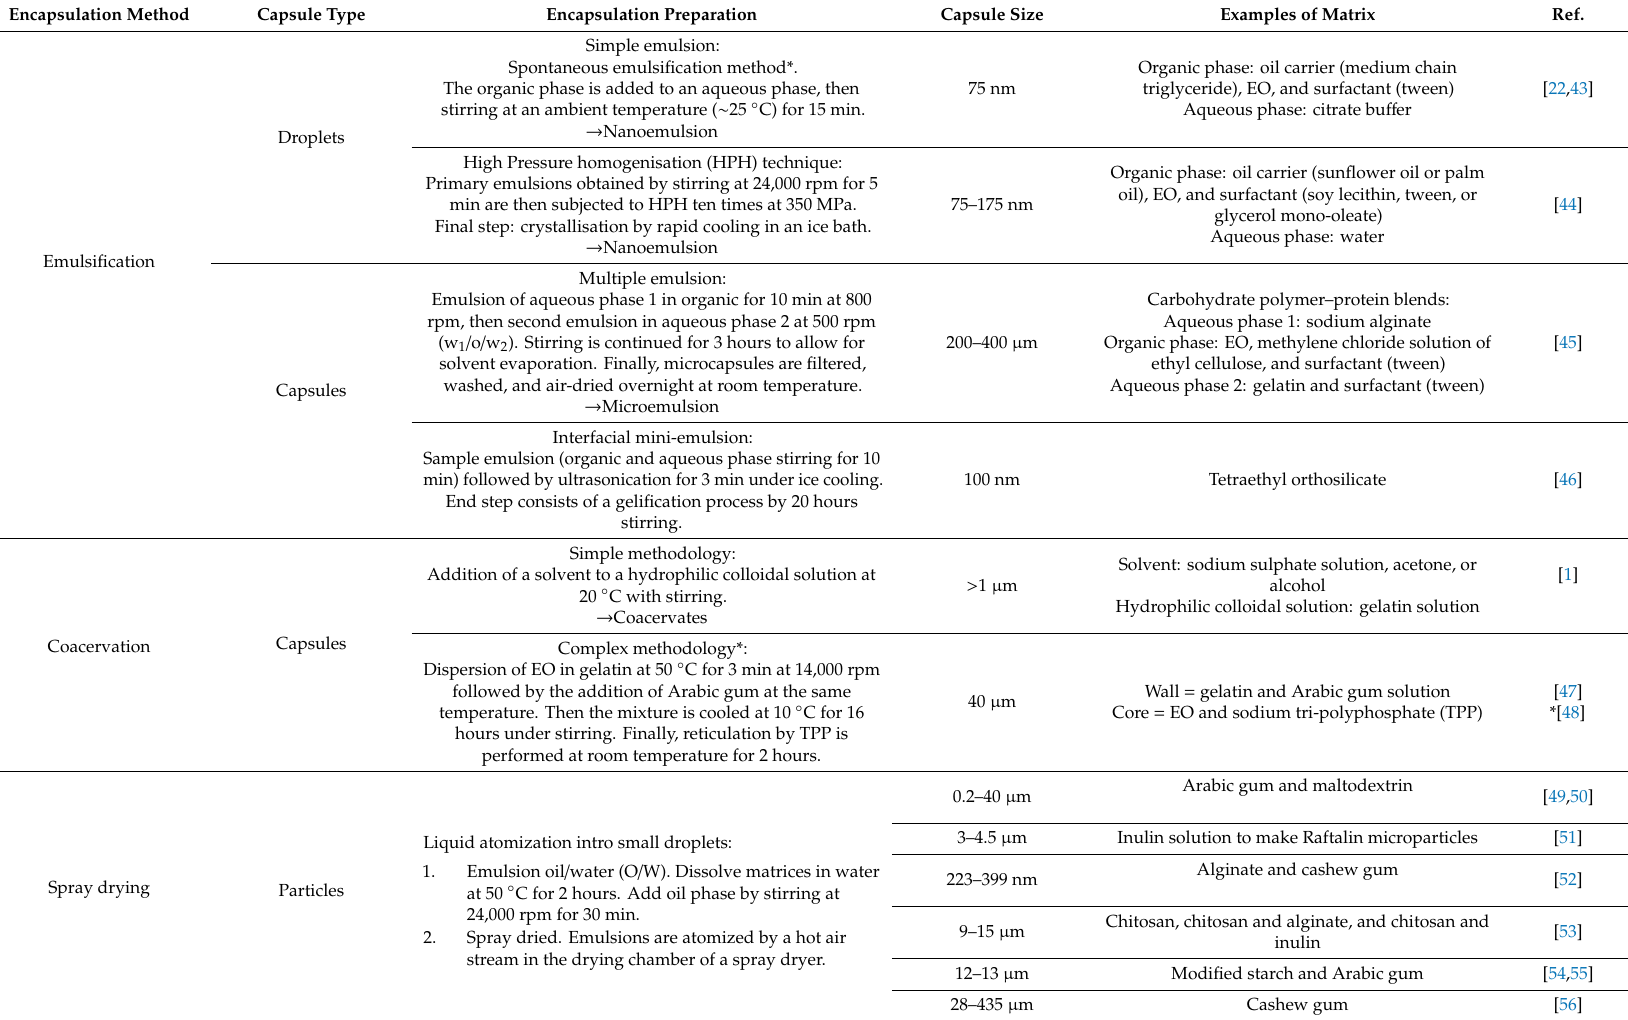
Table 1. Encapsulation techniques of essential oils (EOs) allowing a controlled